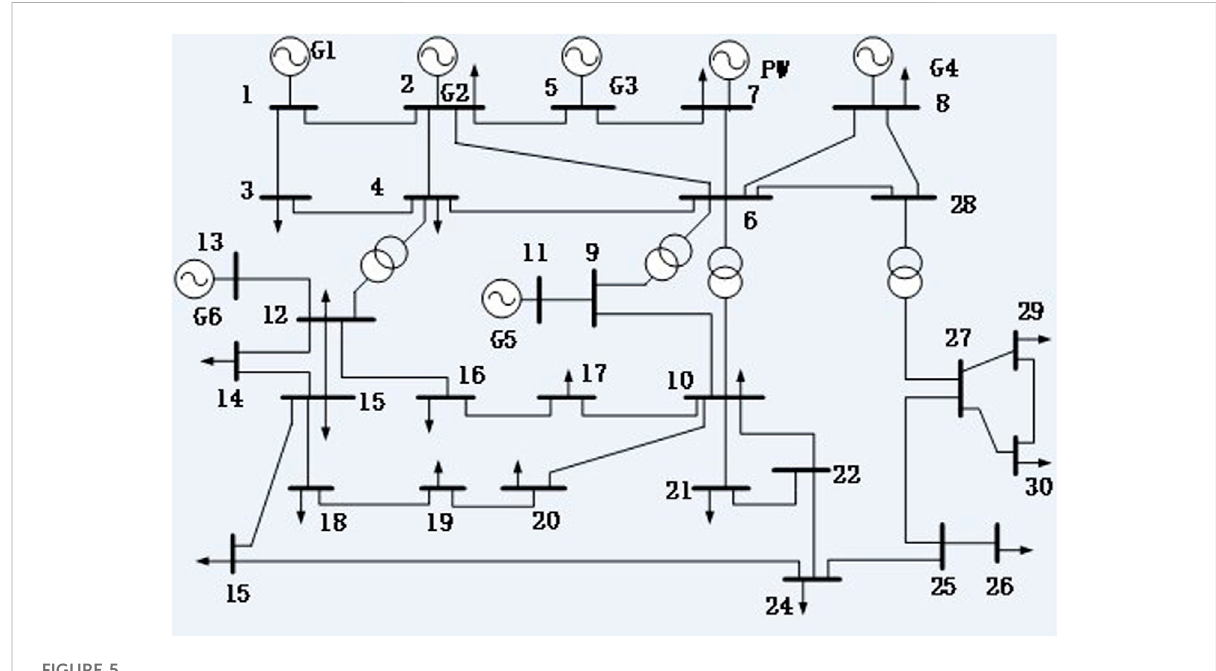
FIGURE 5 Improved IEEE-30 node system wiring diagram.